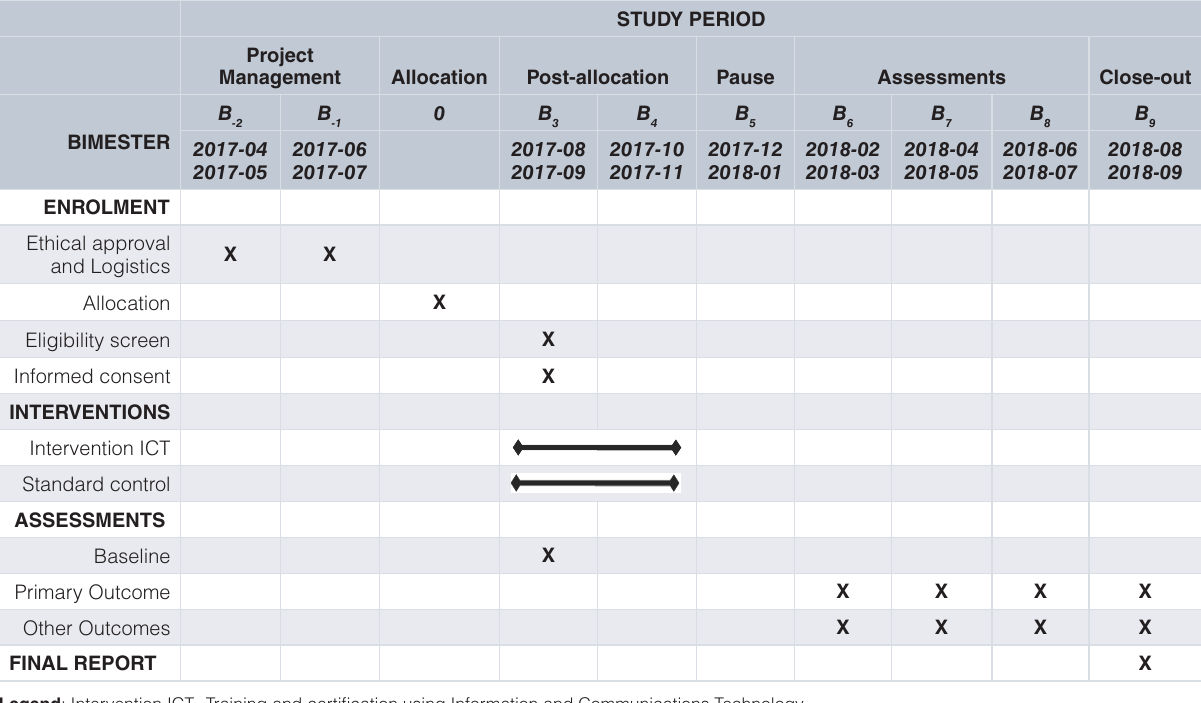
Table 1. Schedule of enrolment, interventions, assessments and final report: RCPNEOPERU